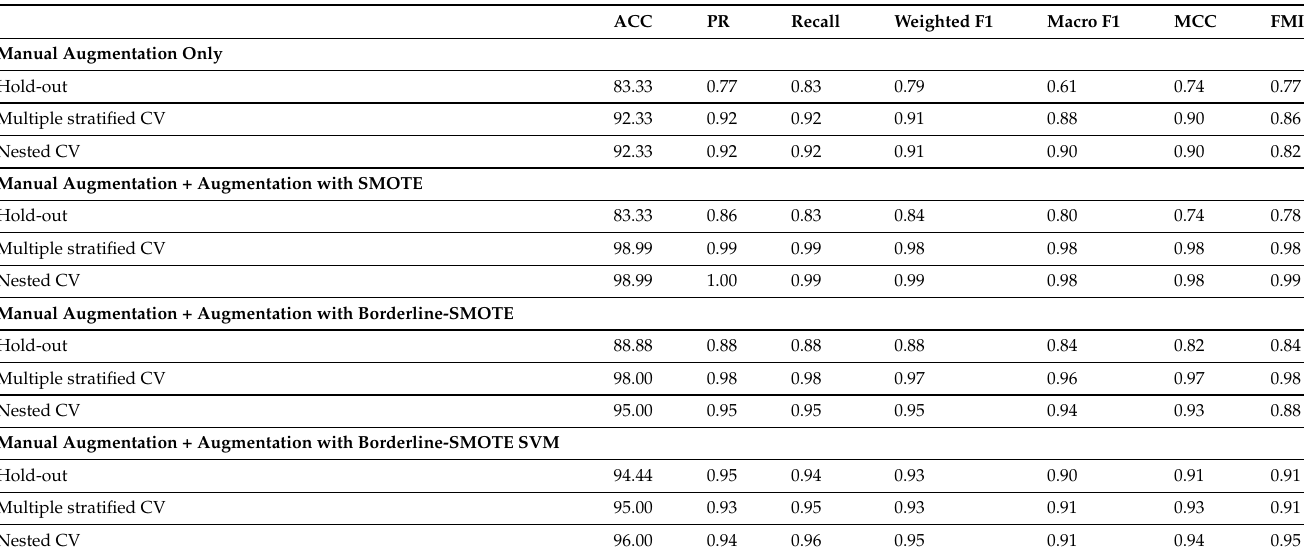
Table 7. Decision tree results for the hold-out, multiple stratified CV, and nested CV methods without using the framework proposed by Pineda-Bautista et al.